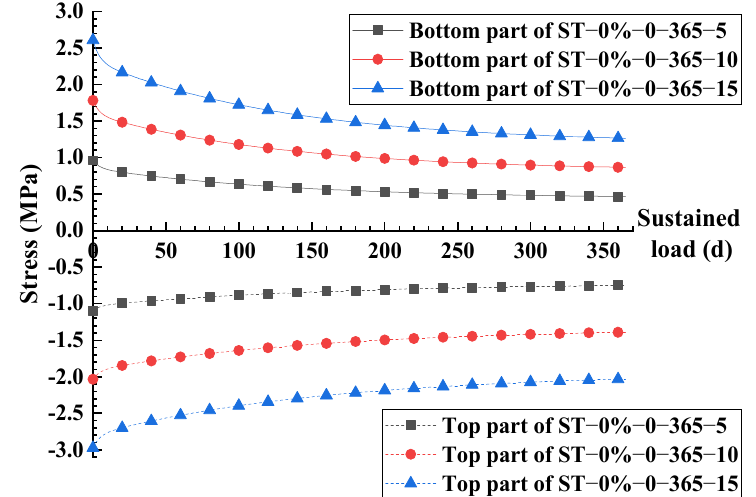
Figure 16. Comparing the stress on the beams under creep at various loading levels. The damage causes the redistribution of the stresses on the concrete in the beam cross section. The initial elastic strain and subsequent strains of the fatigue-damaged beams in-